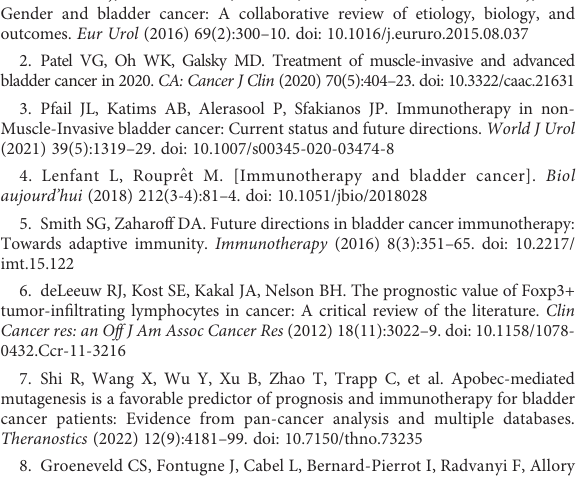
SUPPLEMENTARY FIGURE 2 KEGG analysis of immunotherapy responders.